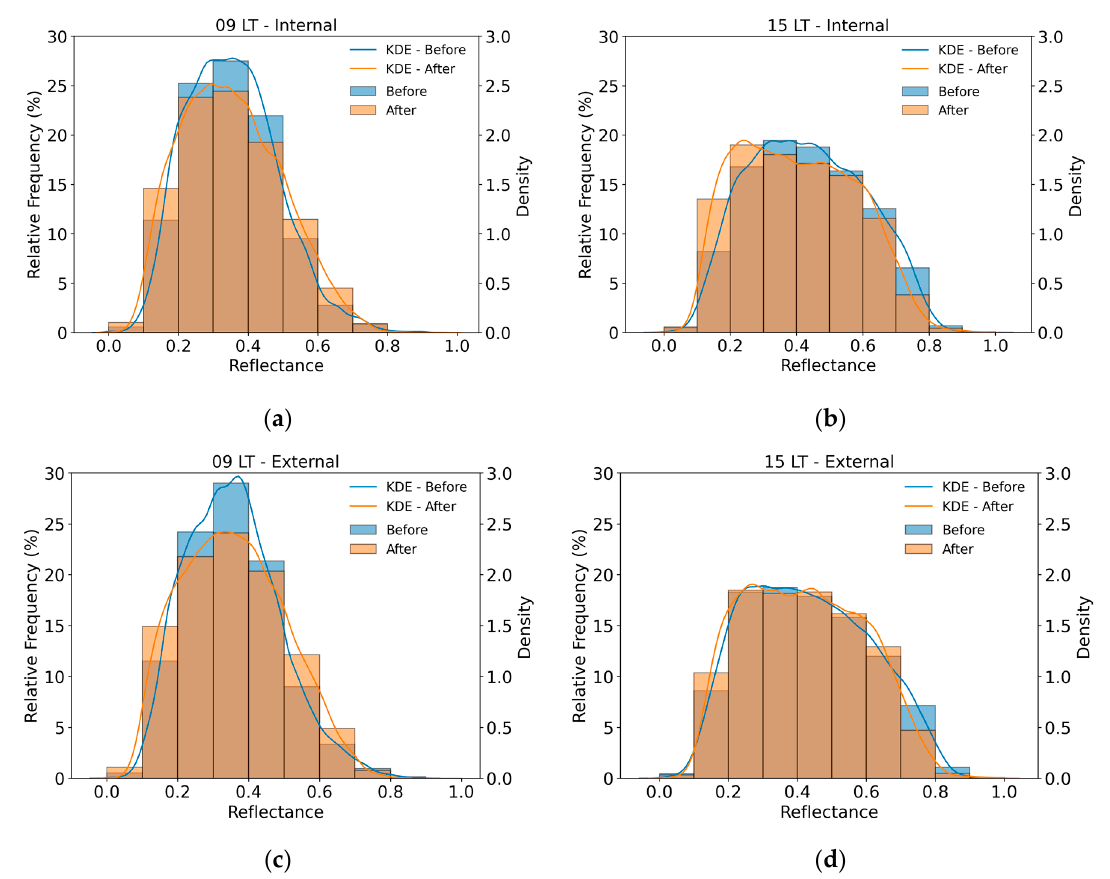
Figure 13. Relative frequency histogram (%) and kernel density estimates (KDE), right axis, of visible reflectance (R) over the water surface area based on GridSat-B1/ISCCPP data acquired before (blue boxes) and after (brown boxes) filling the Serra da Mesa Reservoir: ( a ) 09h LT (morning period) in the internal area; ( b ) 15h LT (afternoon period) in the internal area; ( c ) 09h LT (morning period) in the external area, and ( d ) 15h LT (afternoon period) in the external area.